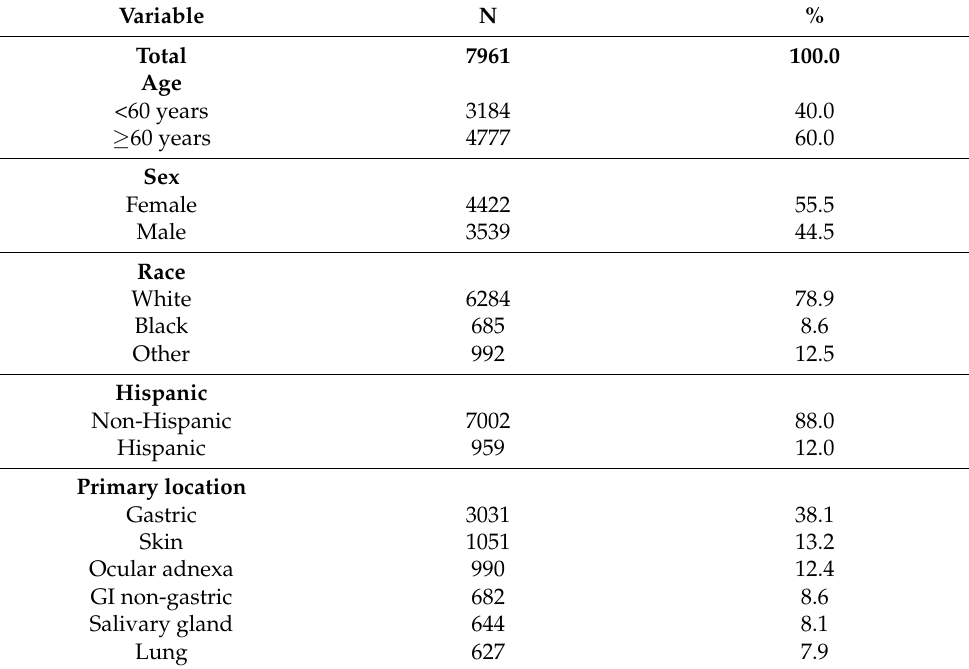
Table 1. Characteristics of stage I EMZL